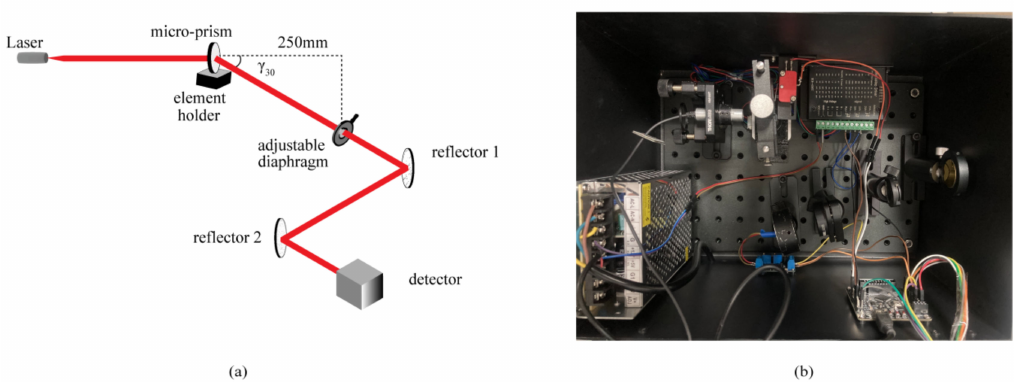
Figure 10. ( a ) Scheme of the developed compact measuring system for testing the prismatic diopter of prisms; ( b ) photograph of the developed compact measuring